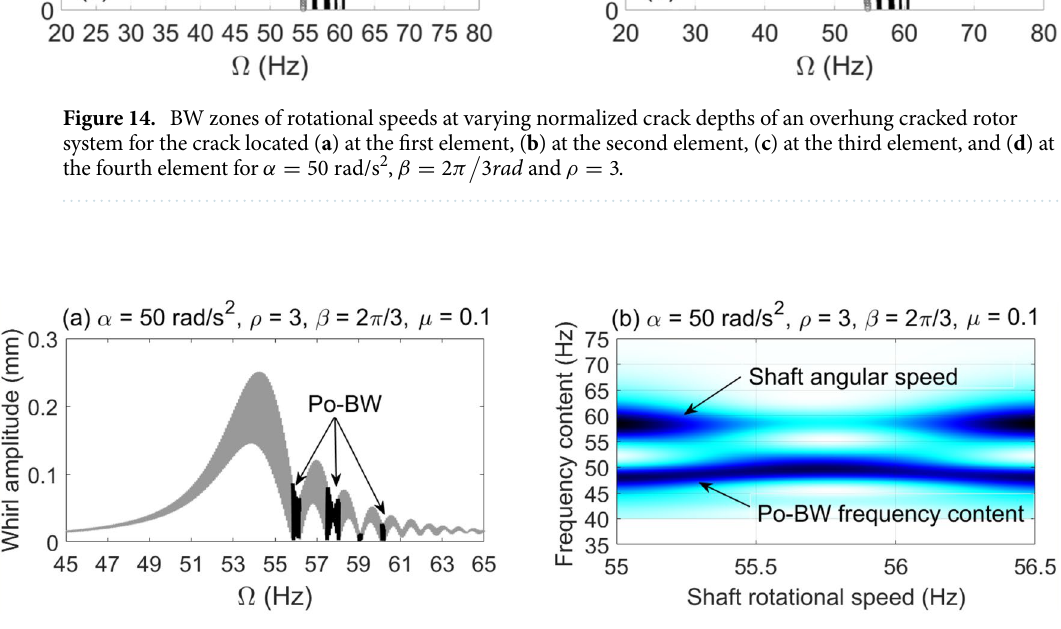
Figure 15. Po-BW zones of rotational speeds of a cracked overhung rotor at element 3 shown in the whirl amplitudes in ( a ), and the corresponding wavelet spectrum transform of the second Po-BW zone in ( b ) at 3 rad , and ρ = 3 µ = 0.1 , α = 50 rad/s 2 , β = 2 π (cid:31)